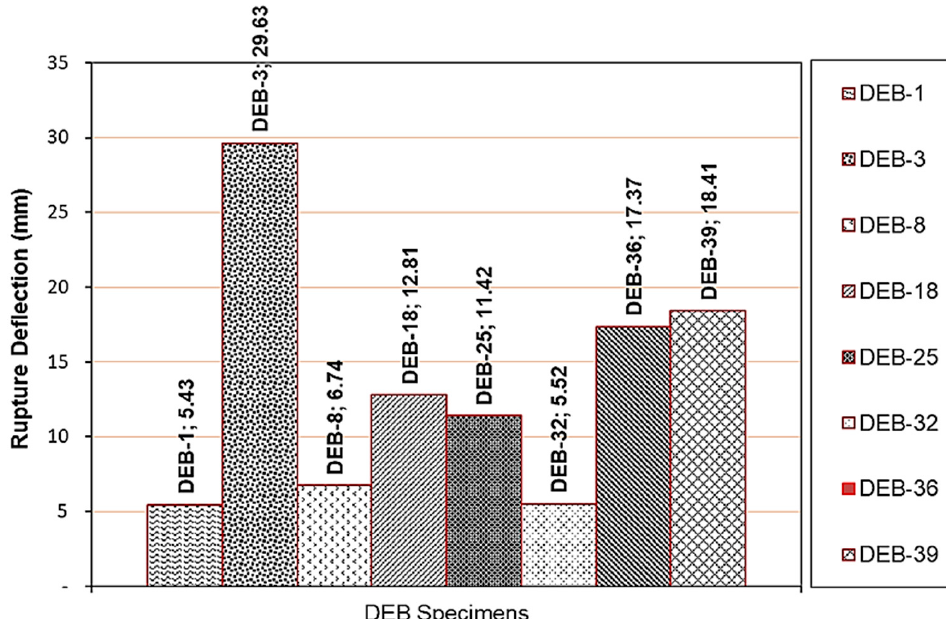
Figure 5. Failure load capacity of DEB specimens.